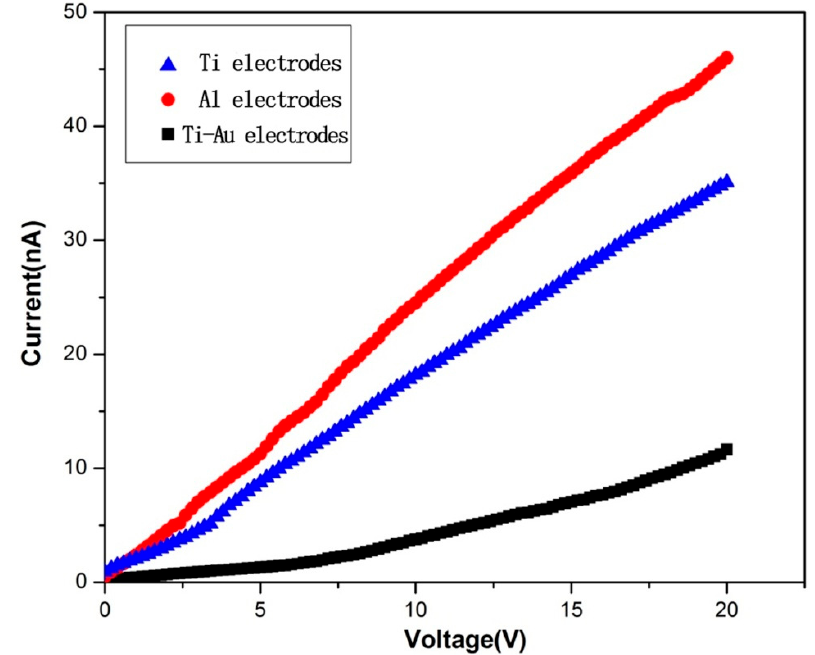
Figure 1. The current–voltage (I–V) characteristic curves of Ti, Al, and Ti-Au electrodes to (111) CdZnTe crystals. Table 1. The current–voltage (I–V) curves fitting results of Ti, Al, and Ti-Au electrodes to n-type (111) CdZnTe crystals.